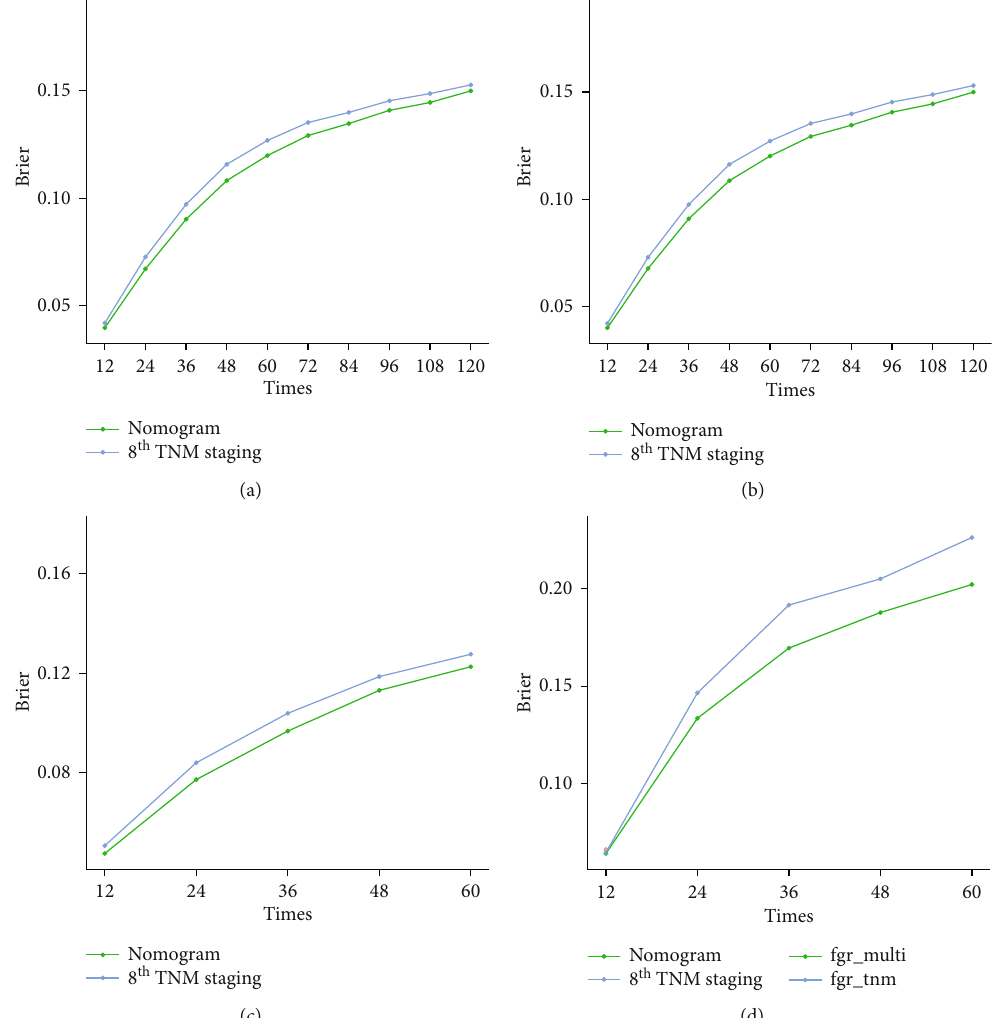
Figure 4: Brier score of the nomogram and 8 th TNM staging in the prediction of prognosis of patients from the 1-year to the 10-year point in the development cohort (a), development cohort with bootstrapped validation (b), validation cohort (c), and test cohort